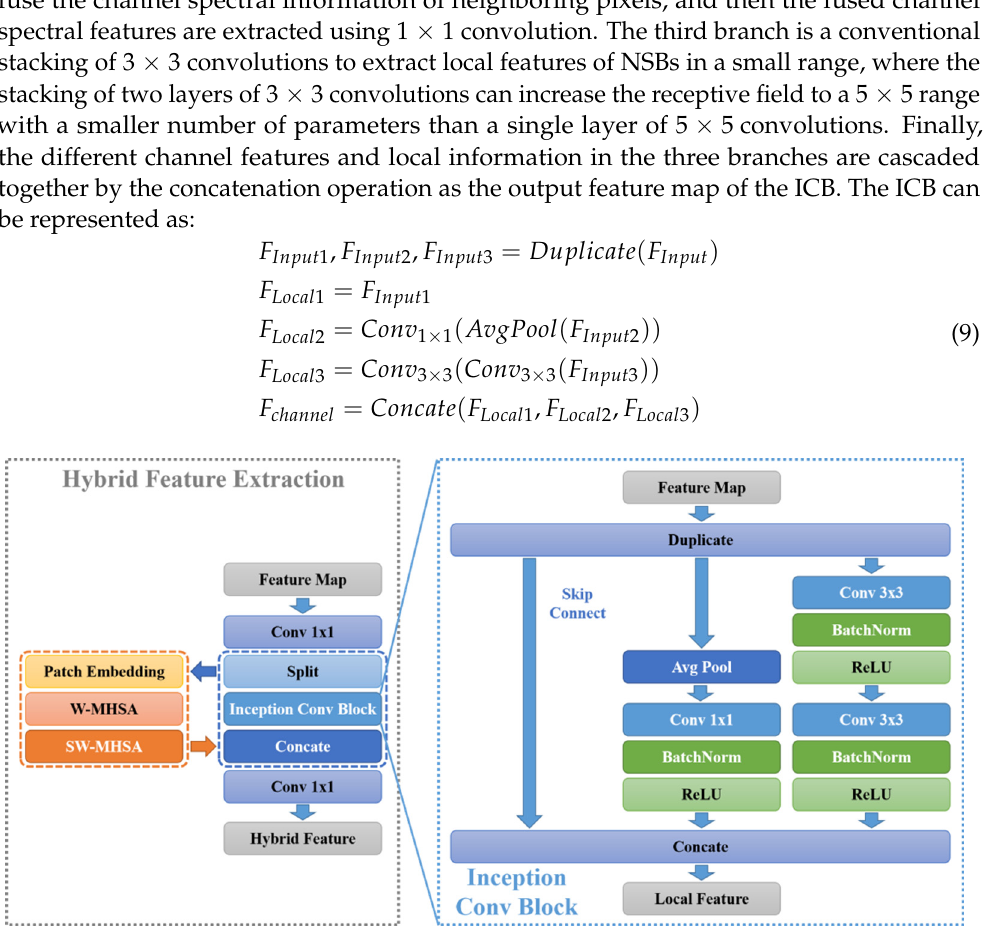
Figure 9. Structure of Inception Conv Block.